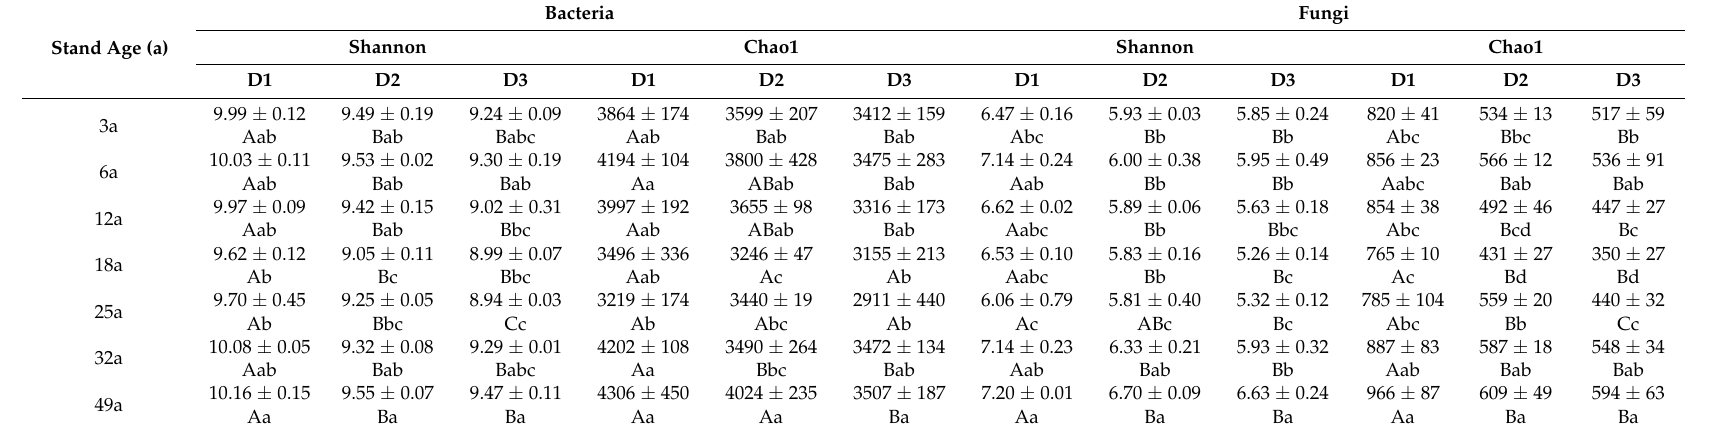
Table 3. Shifts in richness and diversity of microbial communities in different stand